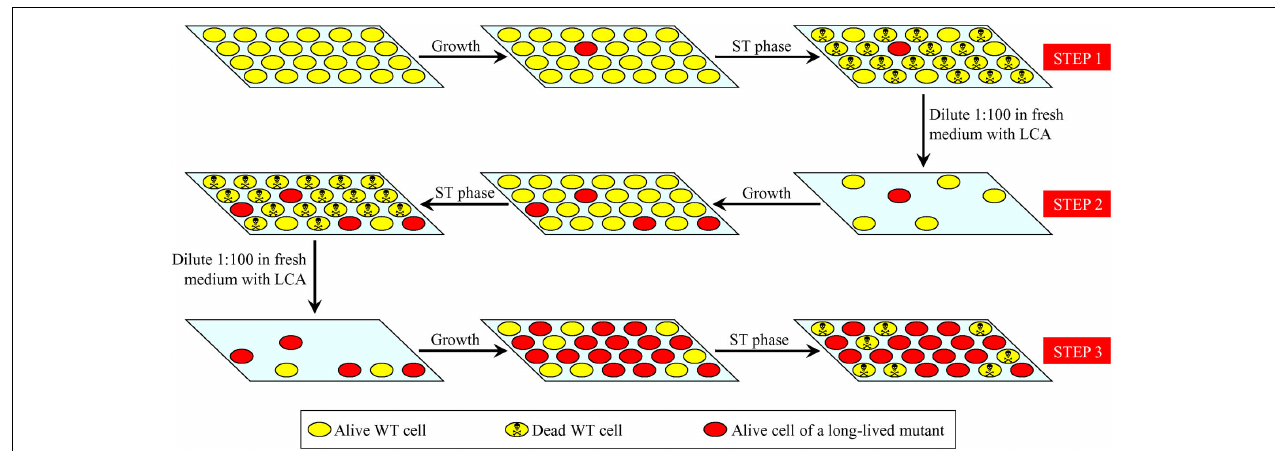
FIGURE 2 | Changes in the percentage of long-lived mutants within a population of yeast during three consecutive steps of the LCA-driven evolution of yeast species that live longer. The percentage of such long-lived mutants in a population of yeast exposed to LCA is increased by the end of each selection step. Each next selection step yields the higher percentage of such mutants than the previous one. See text for details. LCA, lithocholic acid; ST, stationary growth phase; WT, wild-type.